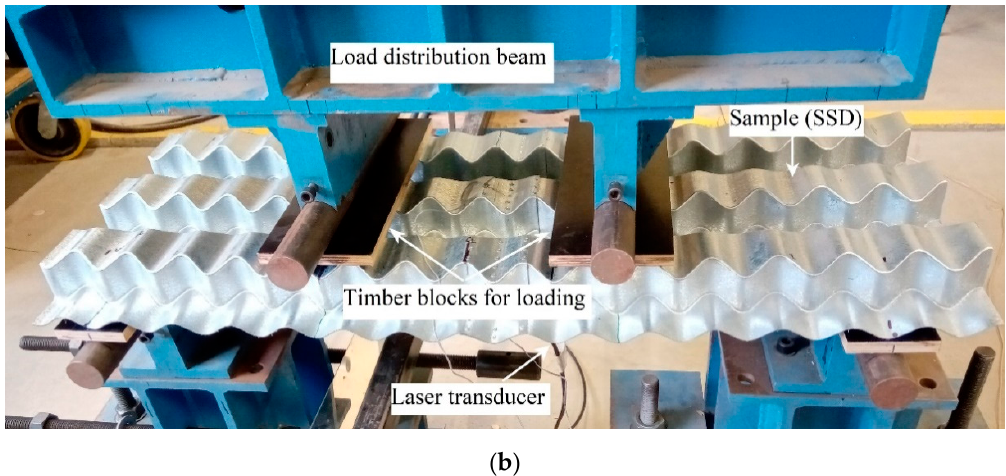
Figure 8. Details of the experimental test of single-span multiple hat sections: ( a ) schematic showing the single-span test set-up for corrugated multiple hat sections; and ( b ) the single span deck test set-up before loading.